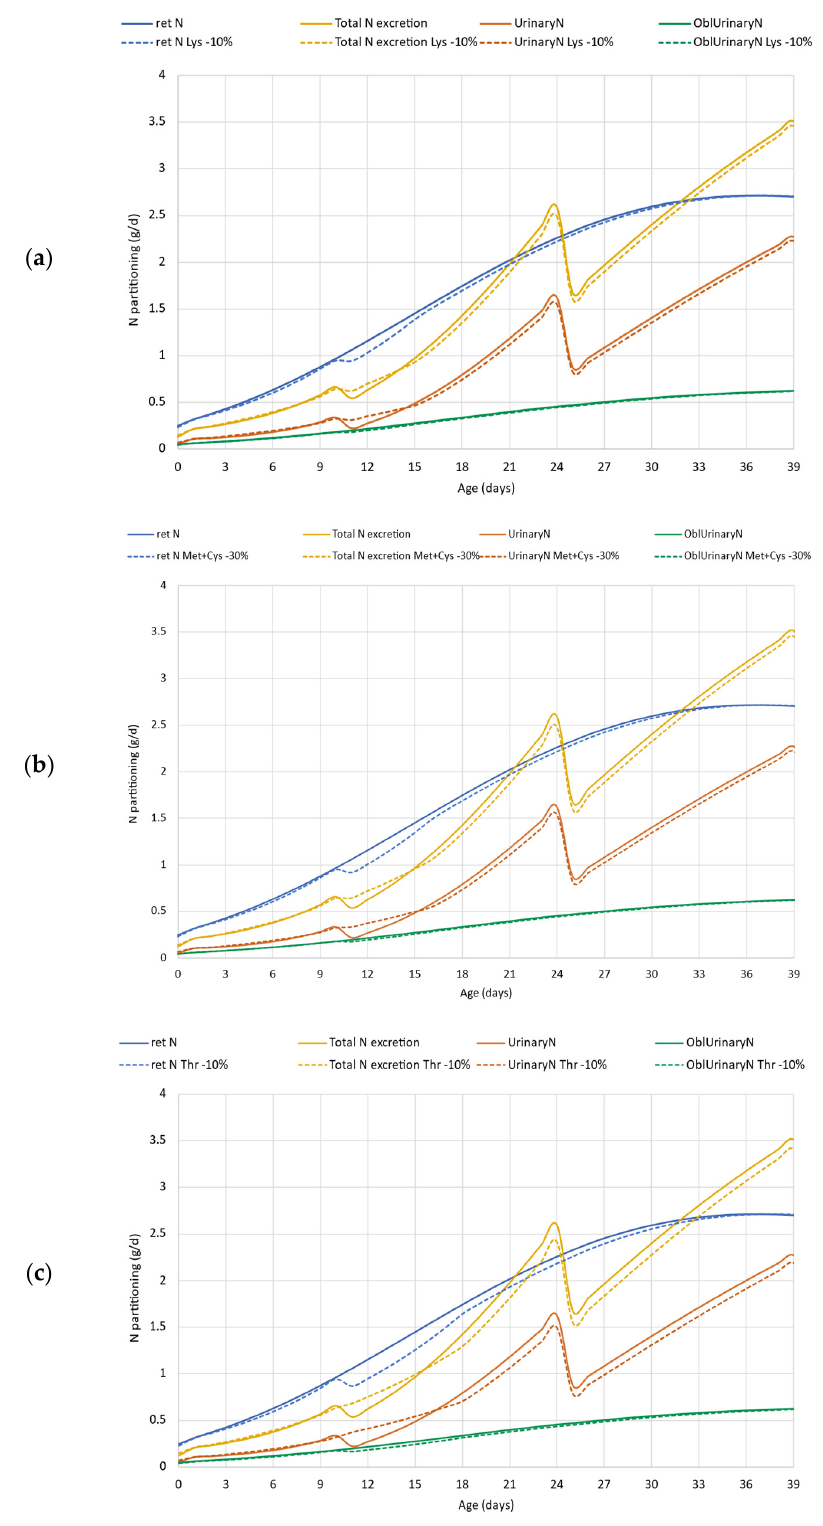
Figure 7. Case study 3. Effect of reduced dietary digestible lysine ( a ), methionine + cystine ( b ) and threonine ( c ) supply on N retention, total N excretion, and its partitioning. ret N—retained nitrogen (g/d); Total N excretion—sum of fecal and urinary N excretions (g/d); UrinaryN—urinary nitrogen excretion, (g/d); OblUrinaryN—obligatory urinary nitrogen loss (g/d); Lys—lysine; Met + Cys— methionine + cysteine;